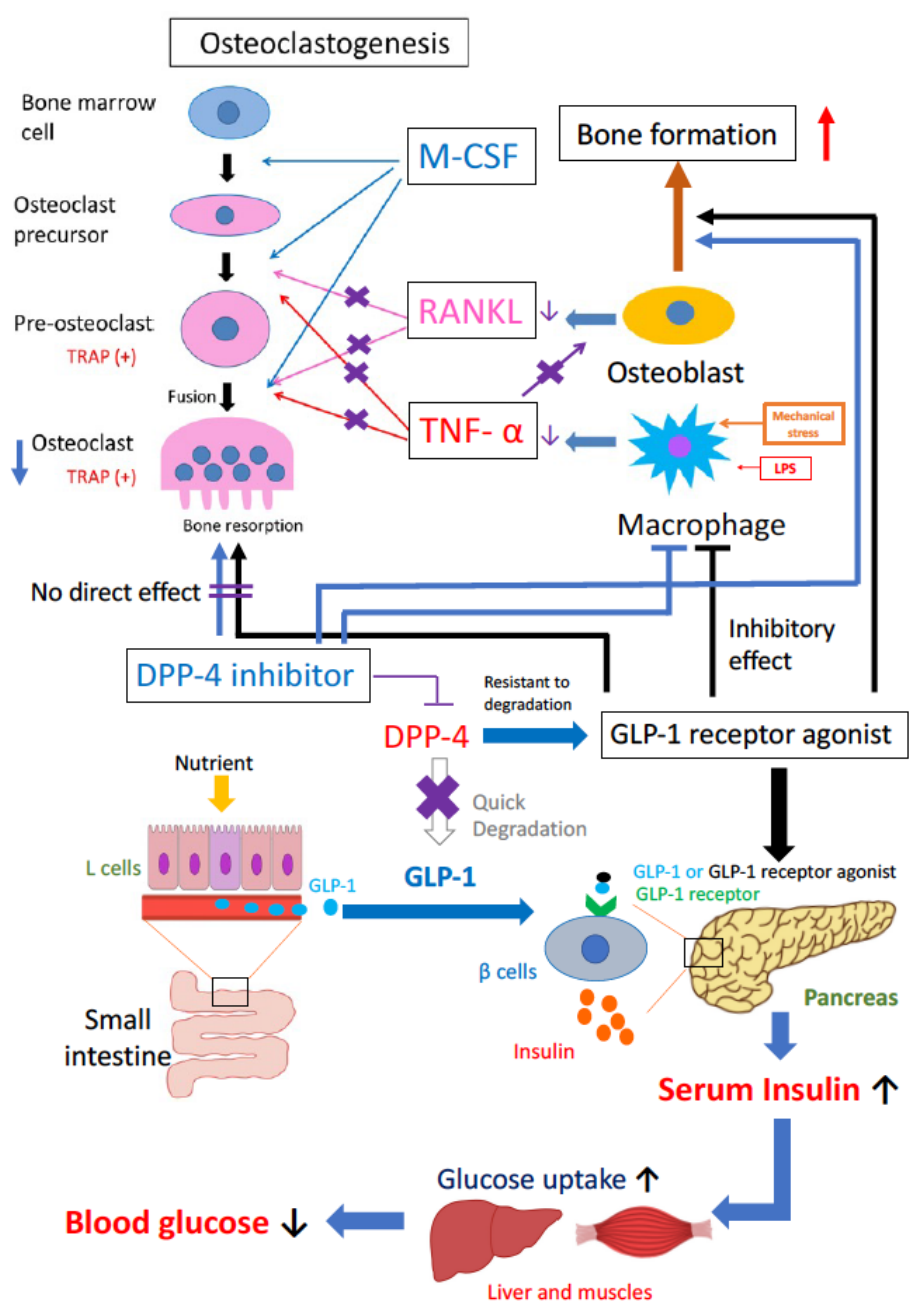
Figure 1. Schematic of the role of incretin-related drugs in osteoclast formation and bone resorption, and osteoblast formation and bone formation. Incretin-related drugs, GLP-1R agonists and DPP-4 inhibitors, may have positive effects on bone metabolism and increase osteoblast ability, decrease osteoclast ability and expression of inflammatory cytokines. The incretin-related drugs can inhibit inflammatory-induced osteoclast formation and bone resorption.